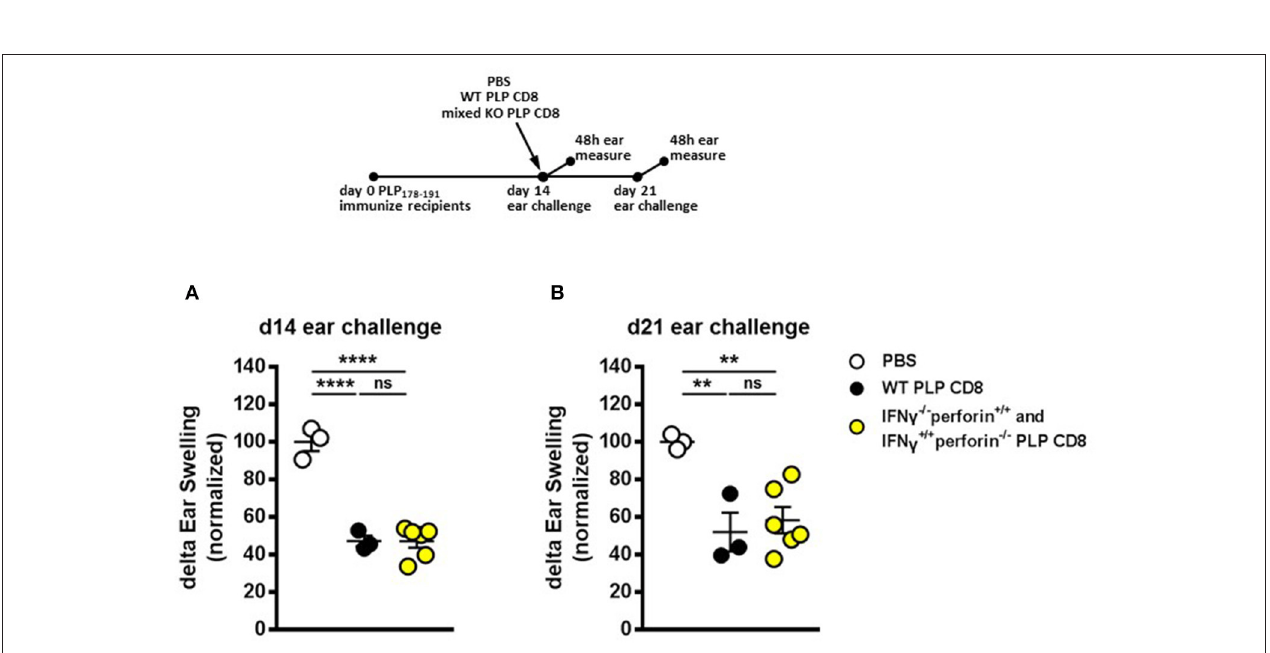
FIGURE 6 | IFN γ –/– and perforin–/– PLP-specific CD8T cells functionally compensate to rapidly suppress PLP-specific CD4T cell responses and maintain longer term suppression in vivo . (A) Mice were immunized with PLP178-191/CFA on day 0. On day 14, mice were treated with either PBS, 5 × 10 6 WT PLP-CD8, or an admixture of 2.5 × 10 6 IFN γ –/– (perforin sufficient) plus 2.5 × 10 6 perforin–/– (IFN γ sufficient) single knockout PLP-CD8. On the same day, ears were challenged with PLP178-191 peptide. Ear swelling was measured at 48h. (B) In the identical setup as (A) , ears were challenged at day 21 (7 days post-CD8 treatment) and swelling was measured at 48h. n = 3–6 per group. ** p < 0.01; **** p < 0.0001.